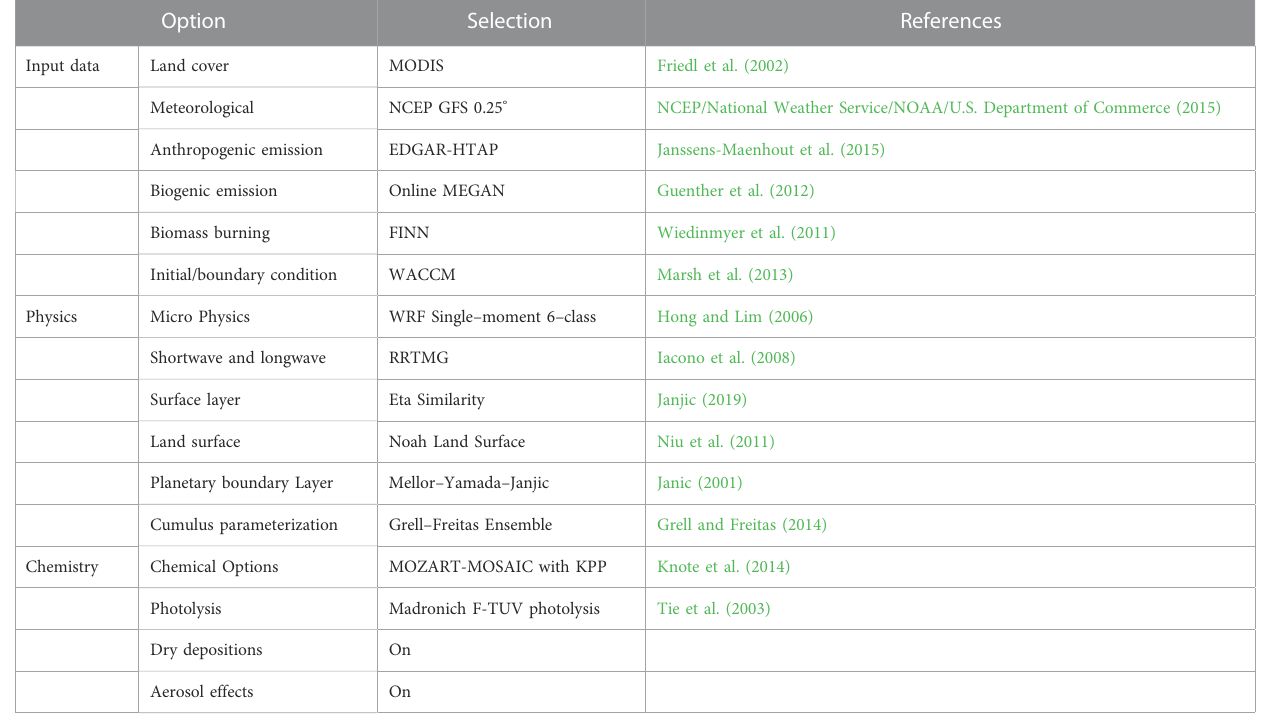
TABLE 1 Input data, physical, and chemical options selected for this